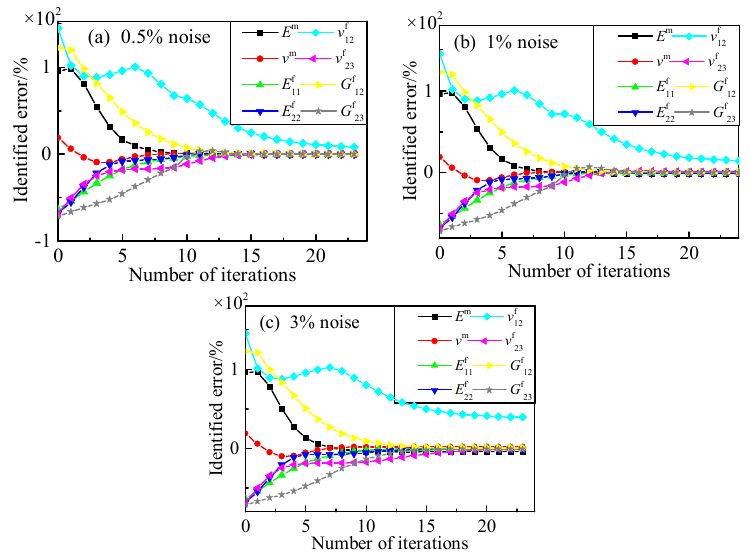
Figure 13. Identified process for constituent parameters of composite plane. ( a ) 0.5% noise; ( b ) 1% noise; ( c ) 3% noise. Table 9. Identified constituent parameters of composite panel.